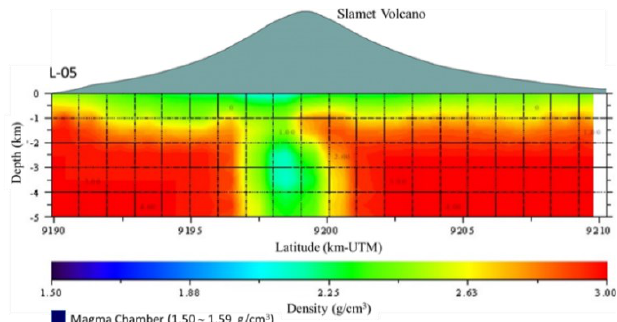
Fig. 13. A cross-section of the anomalous object model along L-04 trajectory at latitude of 9,200.580 km-UTM